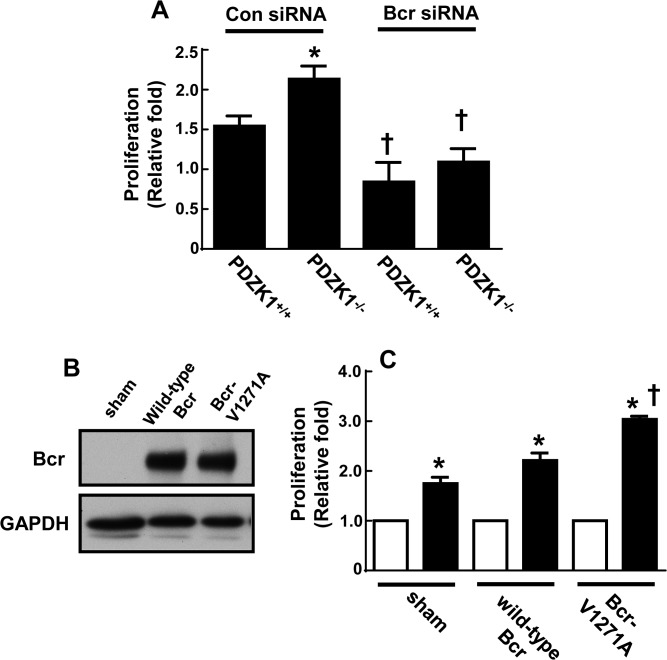
Bcr interaction with PDZK1 blunts VSM cell proliferation.A. VSM cells from PDZK1+/+ or PDZK1-/- mice were transfected with control dsRNA (Con siRNA) or dsRNA targeting Bcr (Bcr siRNA), and cell proliferation in response to PDGF-BB (10 ng/ml) was assessed by quantification of 3H-thymidine incorporation. Effective knockdown of Bcr is shown in Fig 4A. PDGF-BB-stimulated proliferation is expressed relative to proliferation in control, PBS-treated cells. Values are mean±SEM, n = 8, *p<0.05 vs. PDZK1+/+, †p<0.05 vs. Con siRNA. B. VSM cells were infected with adenovirus expressing vector alone (sham), wild-type Bcr or Bcr-V1271A, and relative Bcr expression was evaluated by immunoblot analysis. C. In cells described in B, proliferation was assessed in control PBS-treated cells (open bar) and in response to PDGF-BB (10 ng/ml, closed bar). PDGF-BB-stimulated proliferation is expressed relative to proliferation in control-treated cells. Values are mean±SEM, n = 3, *p<0.05 vs. no PDGF, †p<0.05 vs. wild-type Bcr.